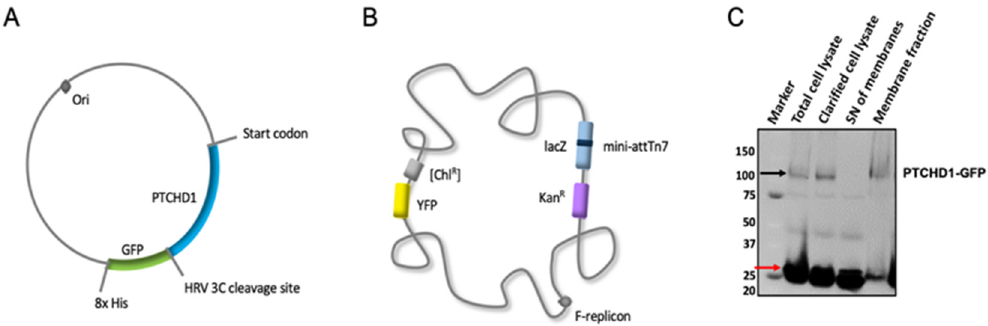
Figure 1. PTCHD1 expression and membrane fractionation. ( A ) A schematic representation of pFastBac ‐ PTCHD1 ‐ CVGH. Ori stands for origin of replication. PTCHD1 is followed by an HRV 3C cleavage site, GFP, and 8x His tag. ( B ) A schematic representation of the MultiBac EmBacY. ( C ) SDS ‐ PAGE of PTCHD1 ‐ GFP expressed in Sf9 cells infected with BIICs shows clear bands around 100 kDa, corresponding to the approximate size of PTCHD1 ‐ GFP (black arrow), and around 25 kDa, corresponding to the native YFP of the MultiBac EmBacY bacmid (red arrow).